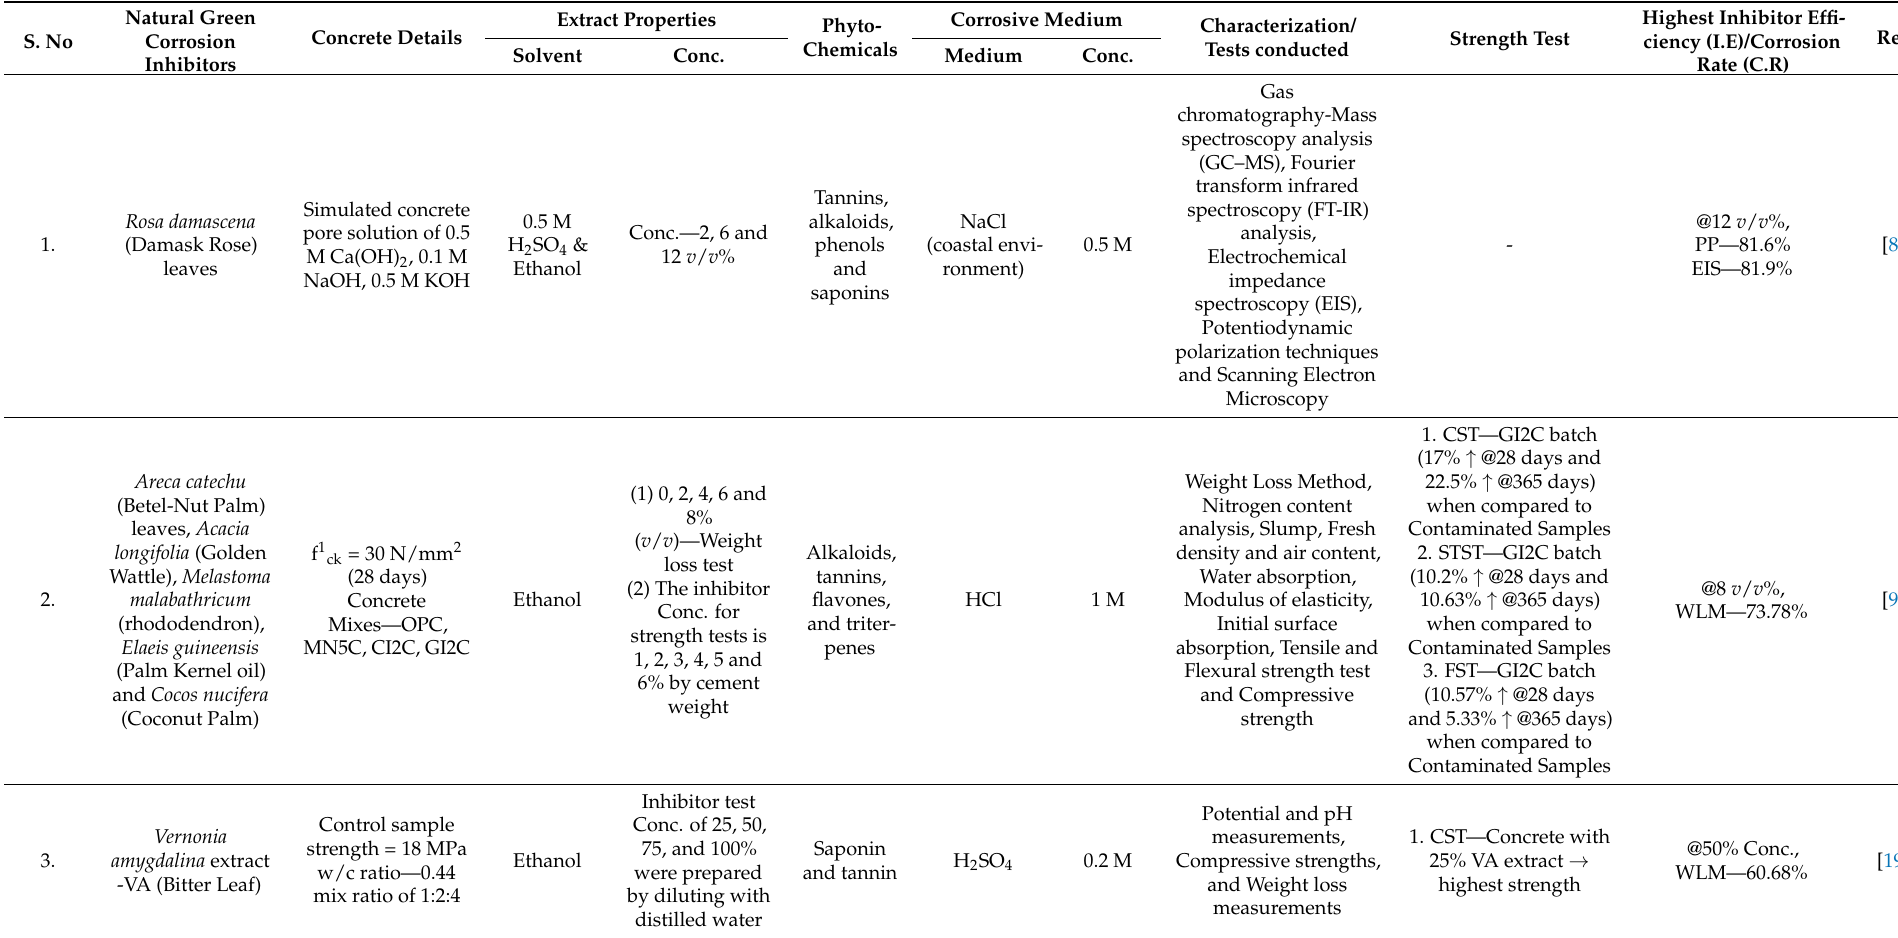
Table 3. Mild Steel